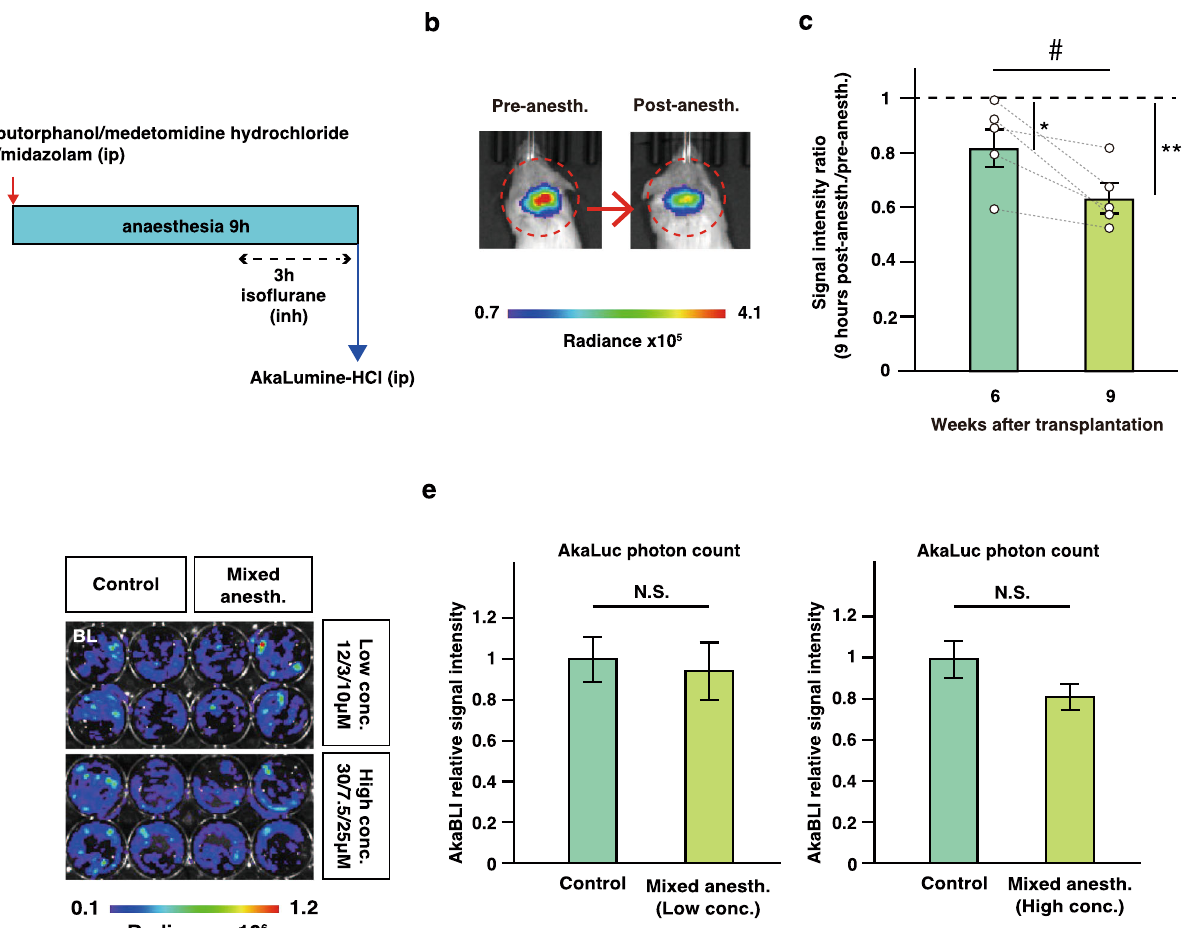
Fig. 3 Continuous anaesthetization of ESAL-expressing NS/PC-transplanted mice. a Schematic illustration of long-term continuous anaesthesia. Anaesthesia was achieved with a mixture of three types of anaesthetic agents (butorphanol, medetomidine hydrochloride, and midazolam) followed